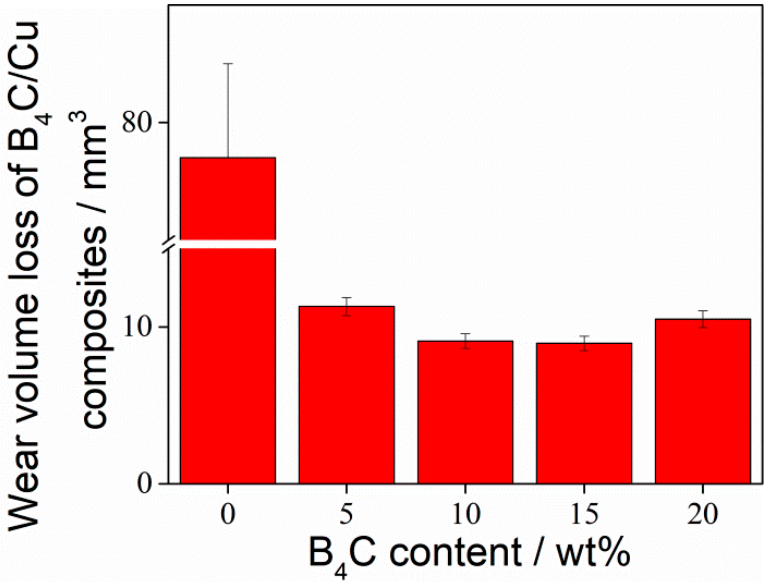
Figure 8. The wear volume loss of the B 4 C/Cu composites with different B 4 C contents.